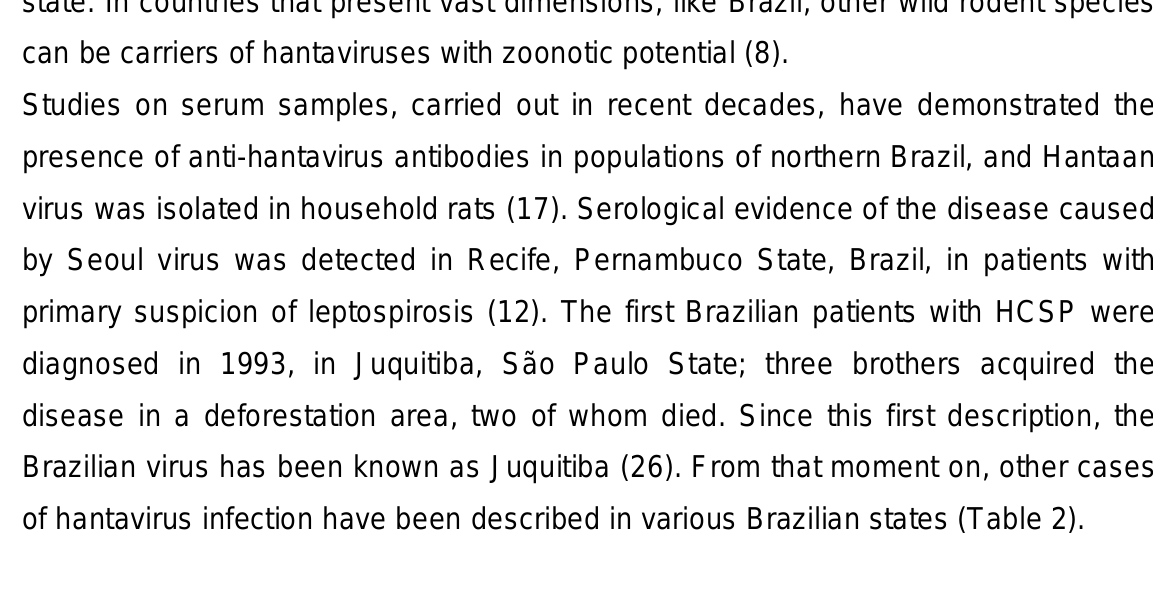
Table 2. Frequency of cases (per year) and lethality caused by hantavirus in Brazil (1993 to 2007) Year Cases Lethality (%) 1993 3 66.7 1995 1 100 1996 1998